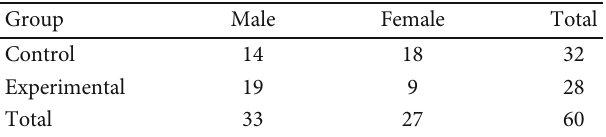
Table 1: Distribution of students in the control and the experimental